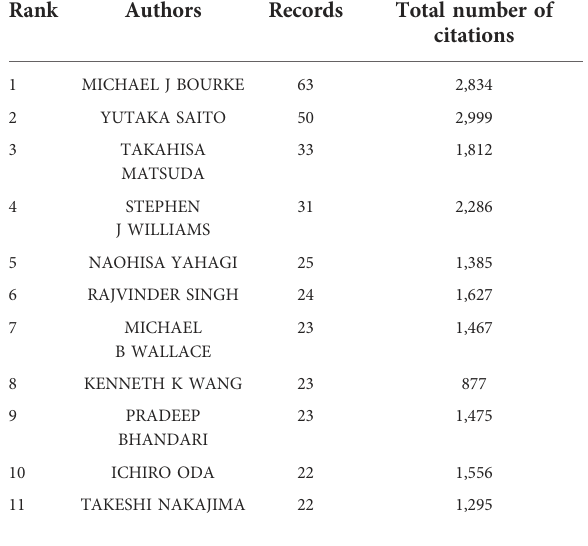
TABLE 4 Top 11 authors in terms of publications.